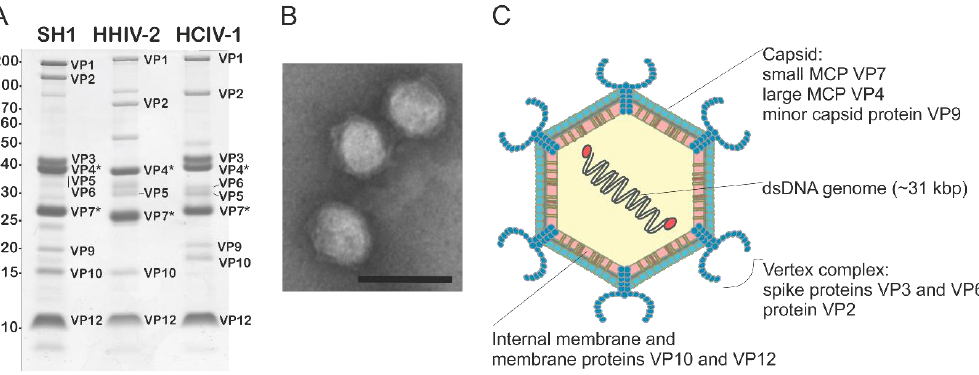
Figure 3. ( A ) Protein profiles of highly purified SH1, HHIV-2, and HCIV-1 virions with structural proteins designated. Asterisks: MCPs. Left column: molecular mass marker (kDa). ( B ) Electron micrograph of highly purified HCIV-1 particles stained with 3% (w/v) uranyl acetate. Scale bar: 100 nm. ( C ) Schematic model of HCIV-1 virion.